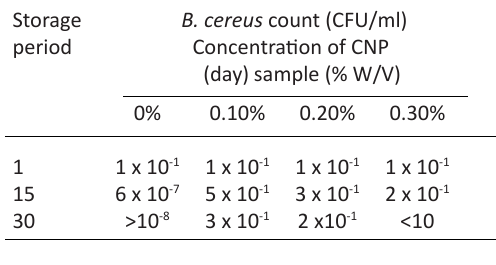
Table 2 . Bacillus cereus count (CFU/mL) of pasteurized milk with chitosan nanoparticals (CNP) at different concentrations (0.1, 0.2 and 0.3% w/v) and without CNP during (1, 15 and 30) days of storage at 5°C.